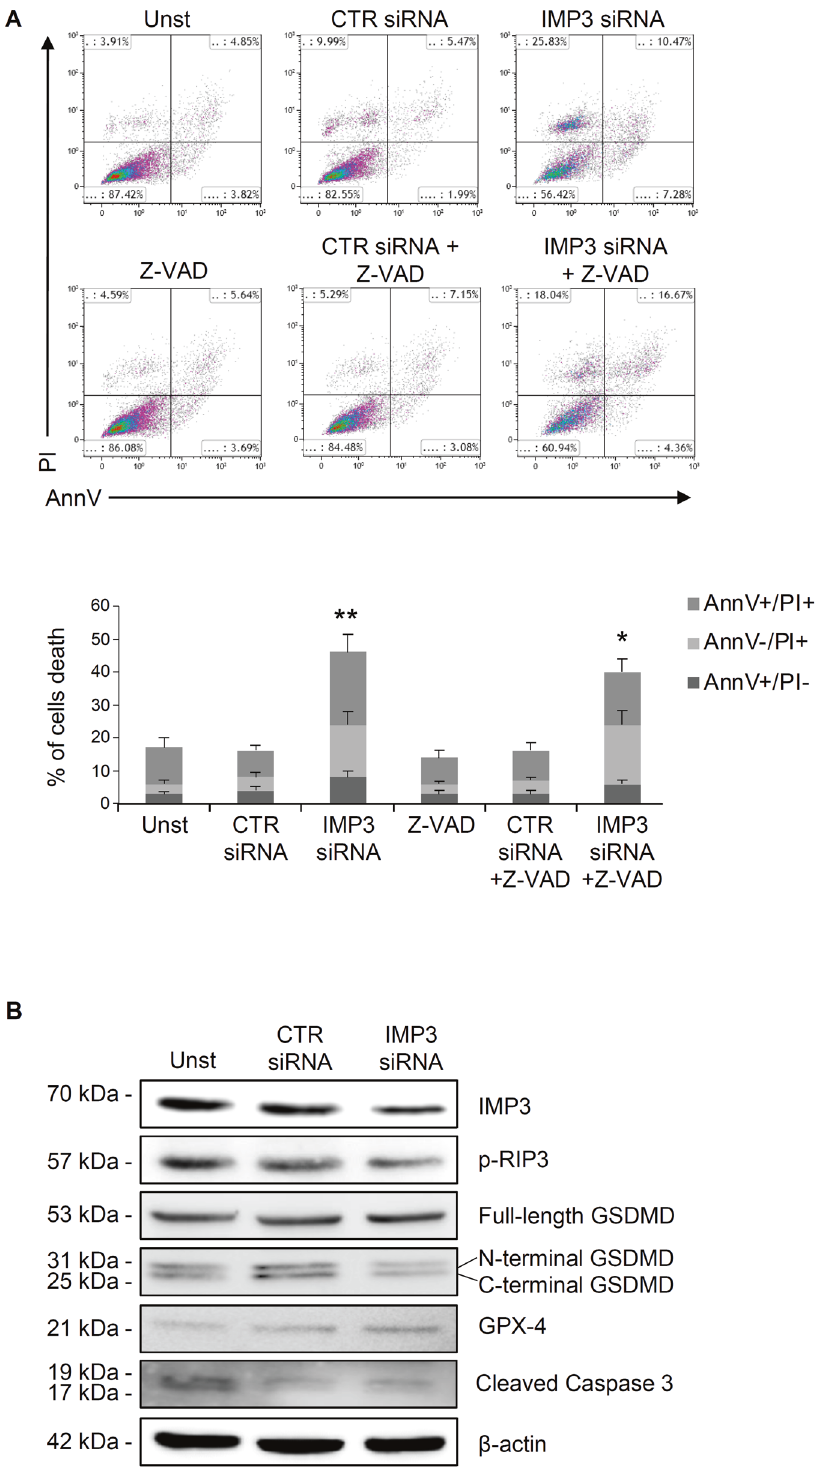
Fig. 4 IMP3-triggered CRC cell death is independent by caspases activation and does not affect necroptosis, pyroptosis or ferroptosis pathways. A Upper panel, representative dot plot showing Annexin V (AnnV) and propidium iodide (PI)-positive HCT-116 cells pre-incubated with pan-caspase inhibitor (Z-VAD) and left untreated (Unst) or transfected with control or IMP3 siRNA for 48 h. Lower panel shows the percentage of AnnV and/or PI-positive HCT-116 treated as above (mean ± SEM; AnnV + PI + unst and CTR siRNA-treated cells versus IMP3 siRNA-transfected cells, ** p ≤ 0.01; Z-VAD-cells and Z-VAD CTR siRNA-treated cells versus Z-VAD IMP3 siRNA-treated cells, * p ≤ 0.05, n = 4). B Representative Western blot of activated form of RIP3 (p-RIP), Gasdermin D (GSDMD), Glutathione peroxidase 4 (GPX4) and cleaved capsase 3 in HCT-116 cells left untreated (Unst) or transfected with control or IMP3 siRNA for 48 h. β -actin was used as loading control ( n = 3).